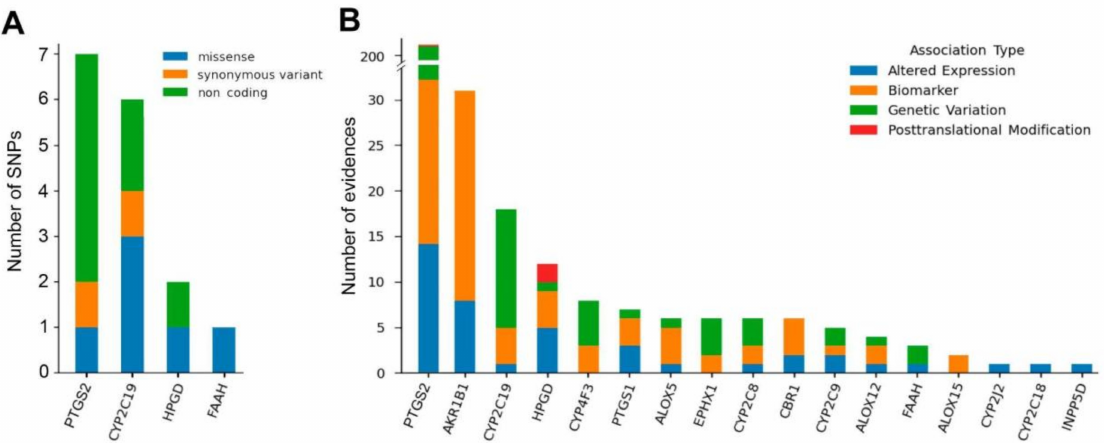
Figure 4. SNPs ( A ) and evidence ( B ) associated with BC for genes involved in oxylipin biosynthesis. In the coding regions, synonymous and nonsynonymous SNPs are